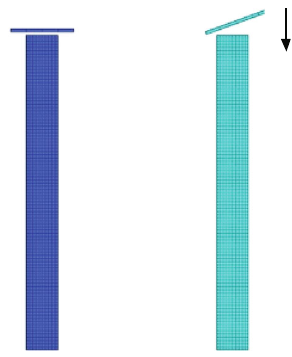
Figure 6: Thin-walled square tube under di ff erent load condition. Table 2: Material performance parameters of fuselage frame section parts.